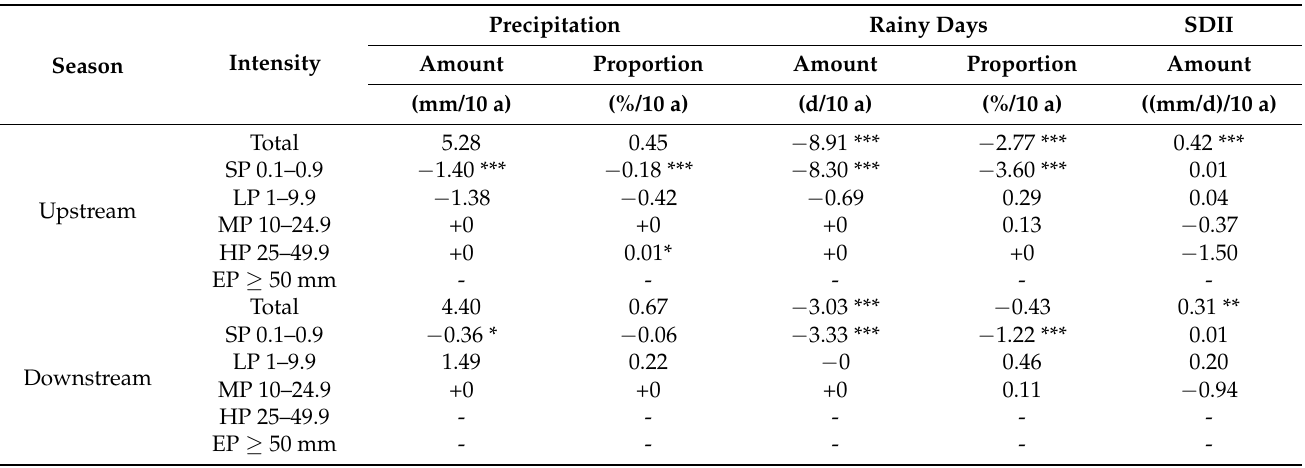
Table 4. Trends of precipitation, rainy days, and SDII in the dry season in each intensity over the LRB during 1977–2017.